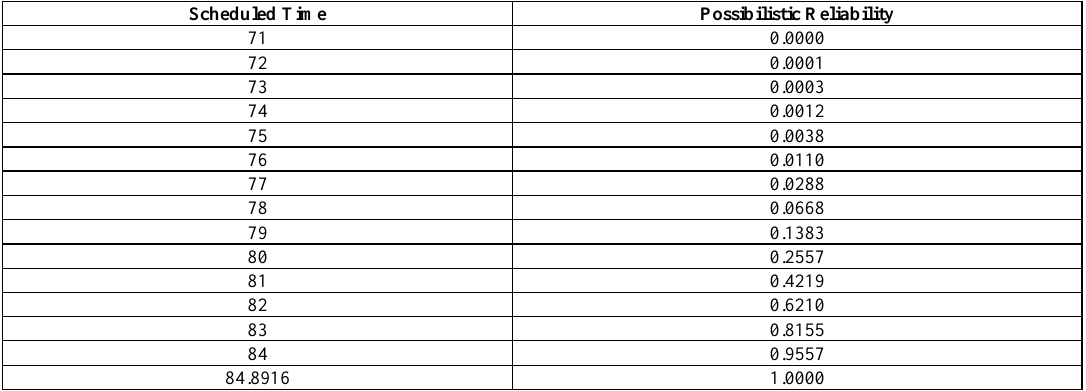
Table 6. Possibilistic reliability values (Third